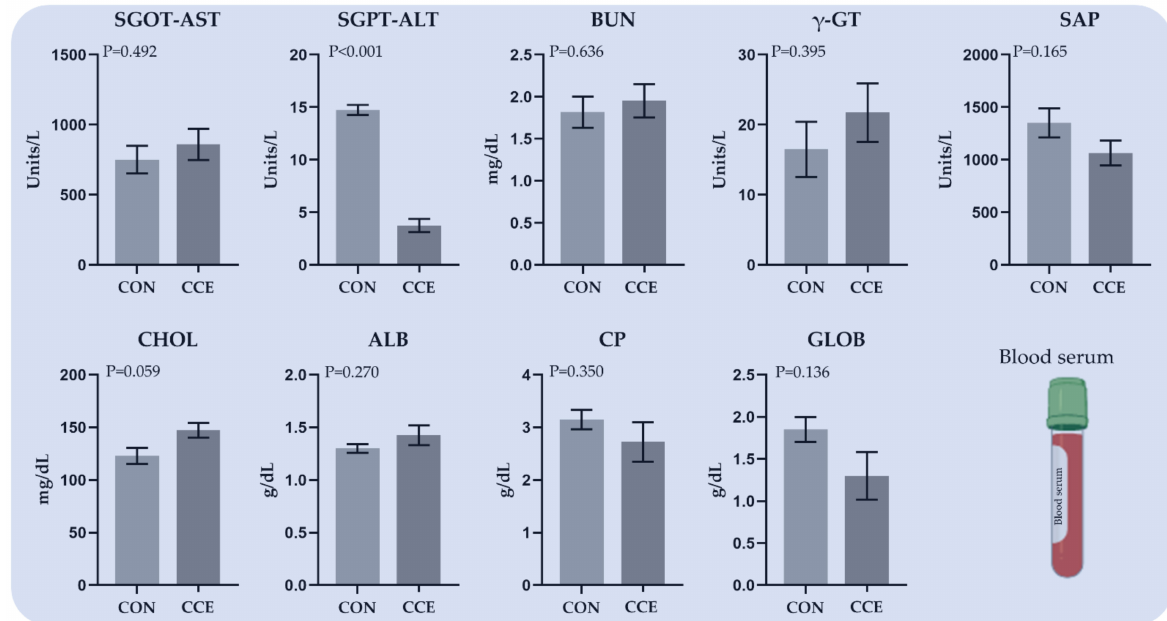
Figure 3. The mean and standard error of means (SEM) of selective hematological and biochemical parameters in blood serum of broilers fed the two experimental diets (Control; CON and carotenoid extract from Citrus reticulata included in soluble starch; CCE) at 42 days. SGOT-AST: aspartate aminotransferase, SGPT-ALT: alanine aminotransferase, BUN: blood urea nitrogen, γ -GT: γ -glutamyltransferase, SAP: alkaline phosphatase, CHOL: cholesterol, and CP: total proteins and fractions of albumins (ALB) and globulins (GLOB) .